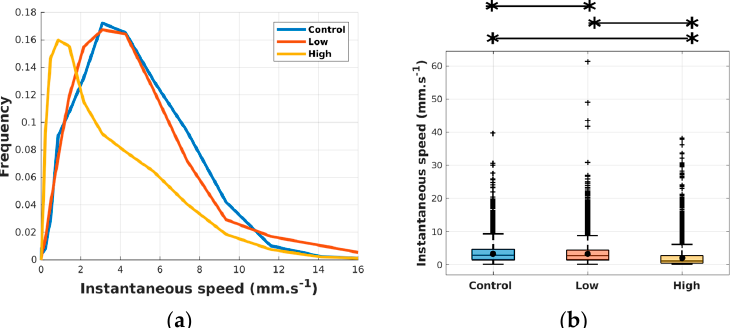
Figure 3. Instantaneous swimming speeds of T. turbinata in the control group (with I. galbana only) and under MP addition at 100 (Low) and 1,000 beads mL − 1 (High). MP treatments contained I. galbana at the same concentration as in the control group. Copepods were observed after being transferred to filtered seawater. ( a ): frequency distribution. ( b ): mean instantaneous speeds, lower and upper limits, and outliers. Horizontal bars on the top of the right panel represent statistical differences between groups.